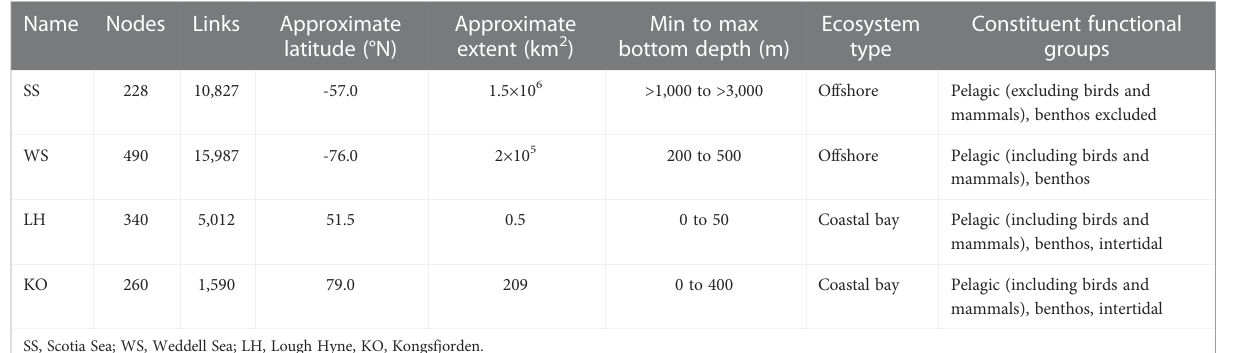
TABLE 1 Characteristics of the four study